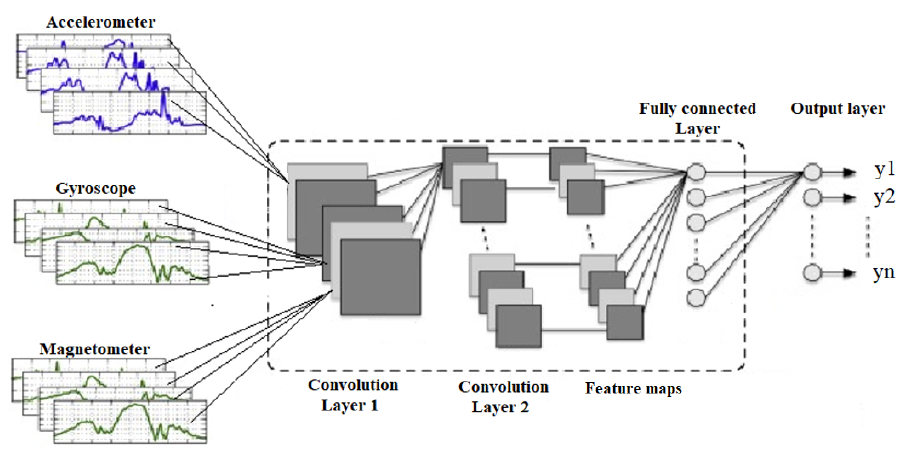
Figure 6. Example of a CNN computational model for inertial signal classification.